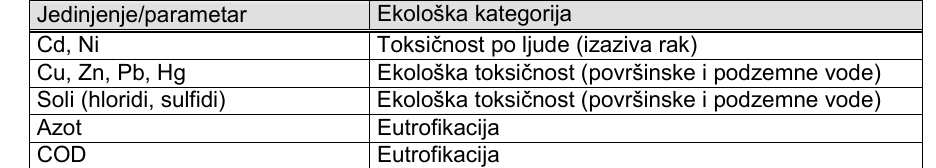
Filtrate from a